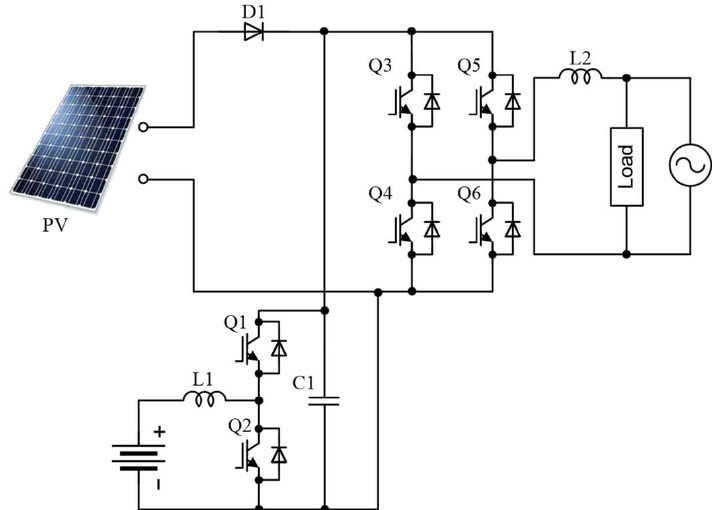
Figure 8. DC Bus MPC with battery boost converter [50].